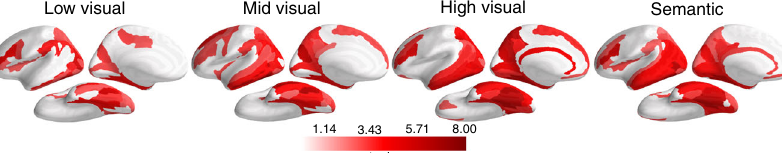
Fig. 2 Neural reactivation during episodic recall. Reactivation for each bilateral ROI and feature level (column = feature). Reactivation was signi fi cantly greater than chance throughout the dorsal and ventral visual streams and within the lateral and orbital frontal cortex during recall. The t -values are thresholded at p < 0.05, one-tailed bootstrap, FDR